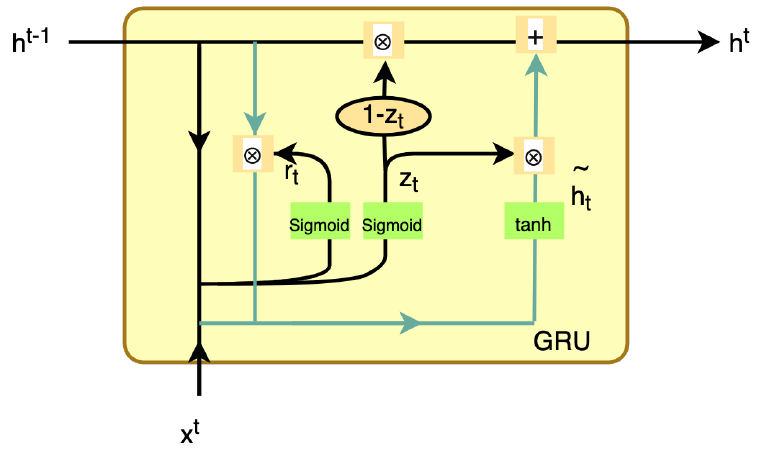
Figure 4. Gate Recurrent Unit (GRU).